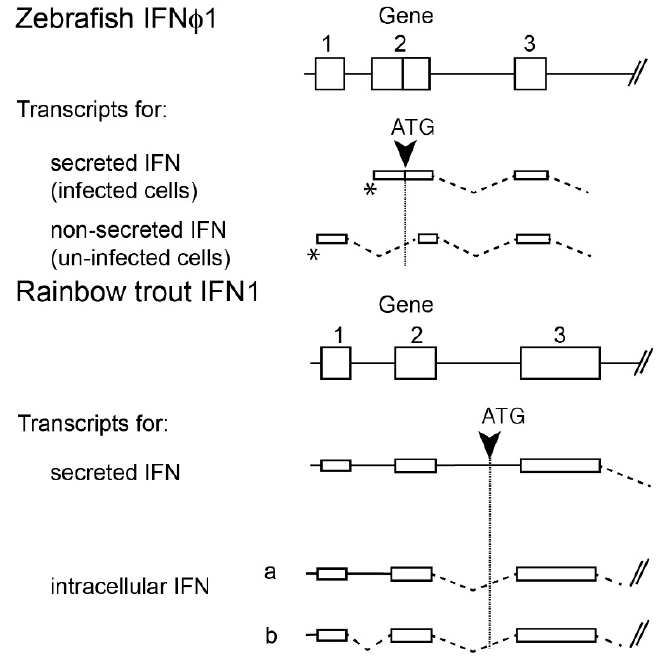
Figure 3. Different mechanisms lead to transcripts encoding secreted and non secreted IFN (group I). Exons (numbered 1–3) are represented as boxes. In transcripts, spliced introns are represented by dotted lines, while plain lines correspond to un-spliced introns. ATG corresponding to the secreted IFN open reading frame (ORF) are indicated by a black arrow. * denote alternative transcription start points in zebrafish. Note that mechanisms leading to production of mRNA encoding secreted IFN are different in zebrafish and rainbow trout (alternative transcription start versus alternative splicing). Adapted from [27,30,31].